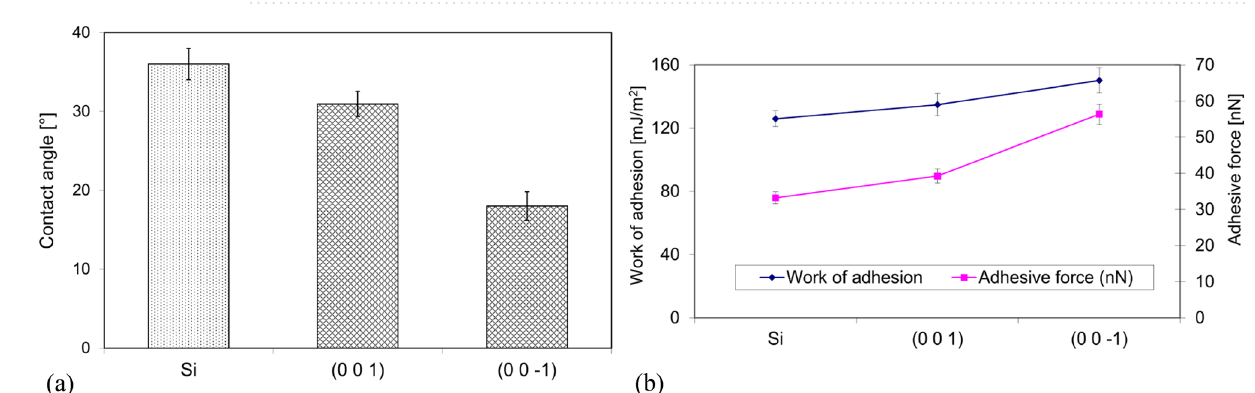
Figure 3. Contact angle ( a ) and ( b ) work of adhesion vs. adhesive force for (001) and (00 1 ) faces of